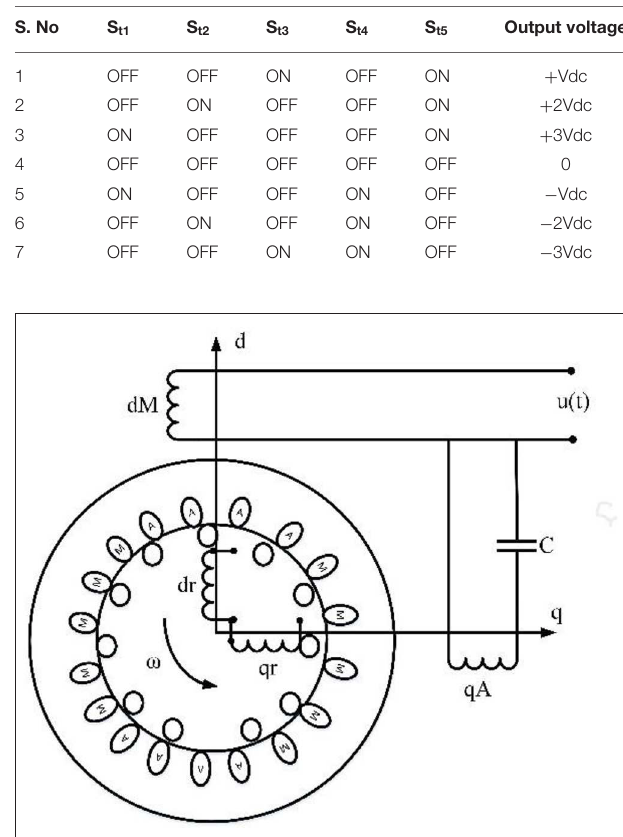
TABLE 1 | Switching pattern of seven-level inverter with five switches.